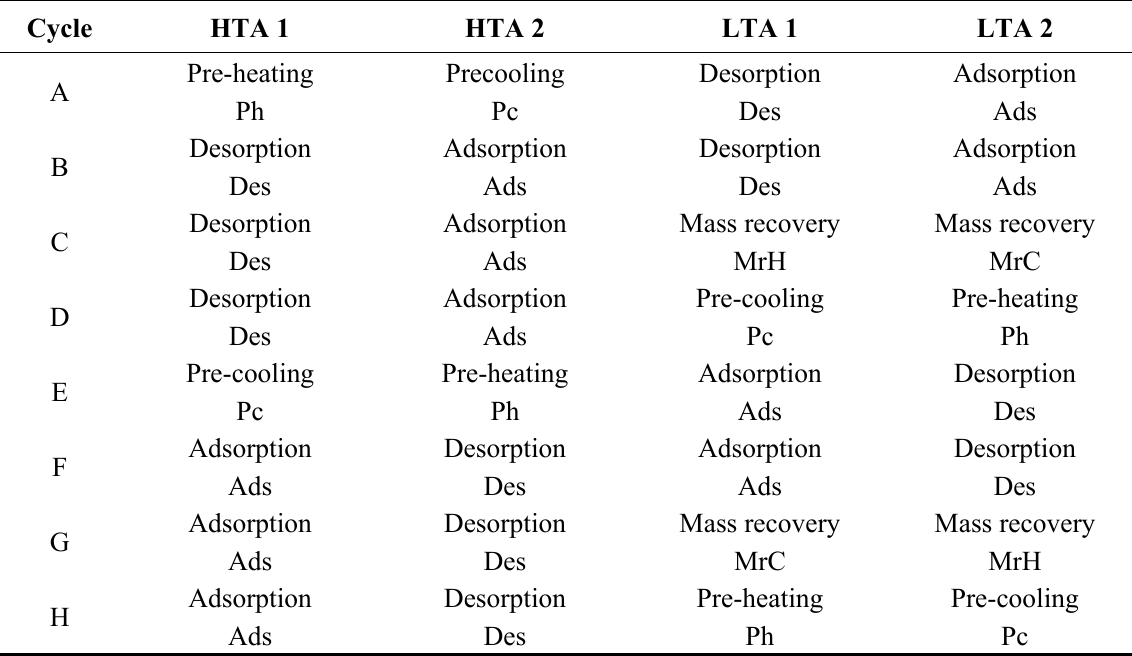
Table 2. Operation scheme of the proposed cascading cycle.